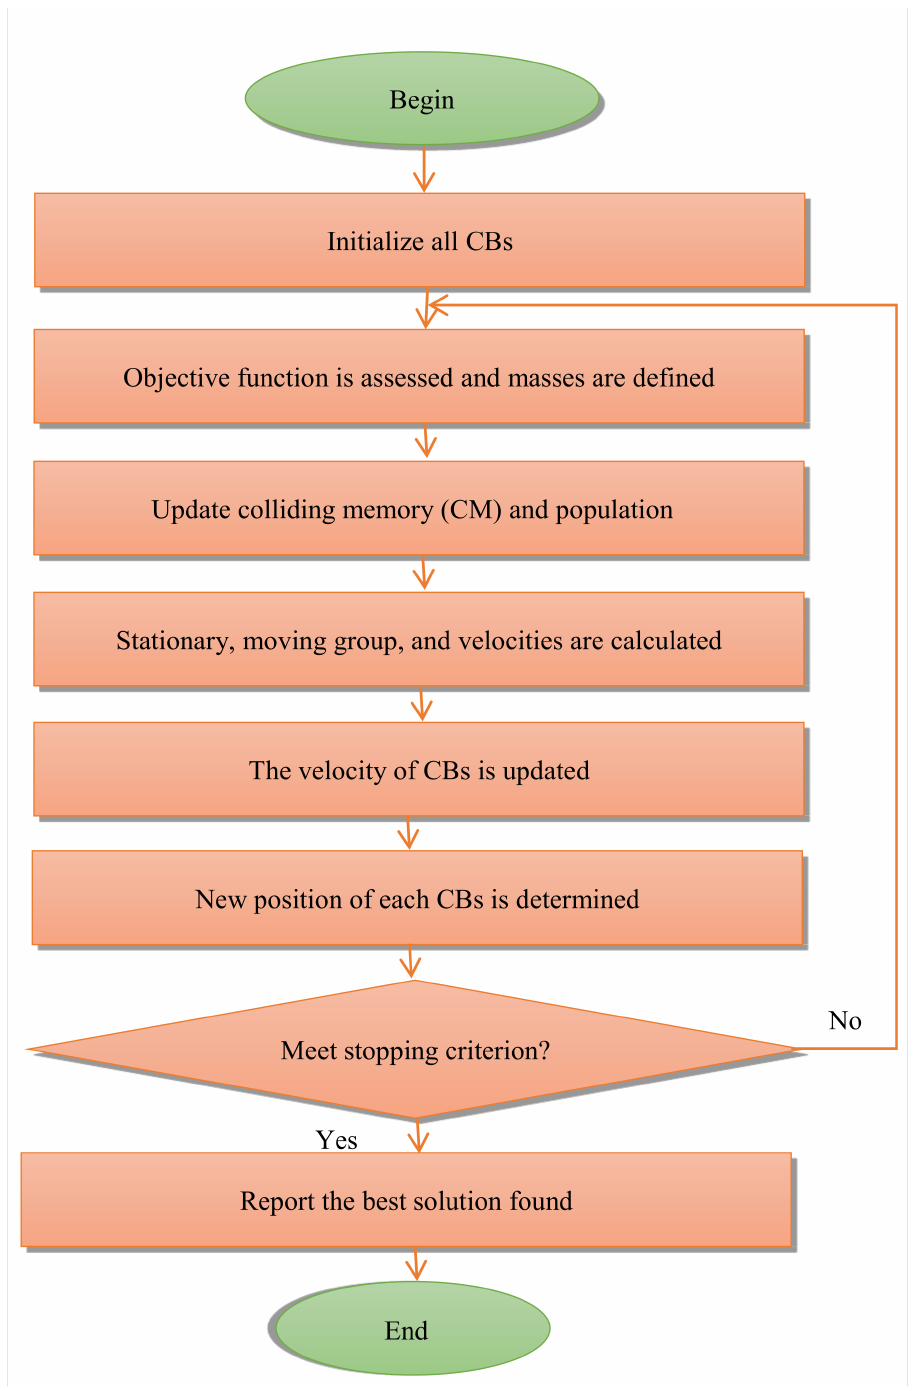
Figure 4. Flowchart of the ECBO